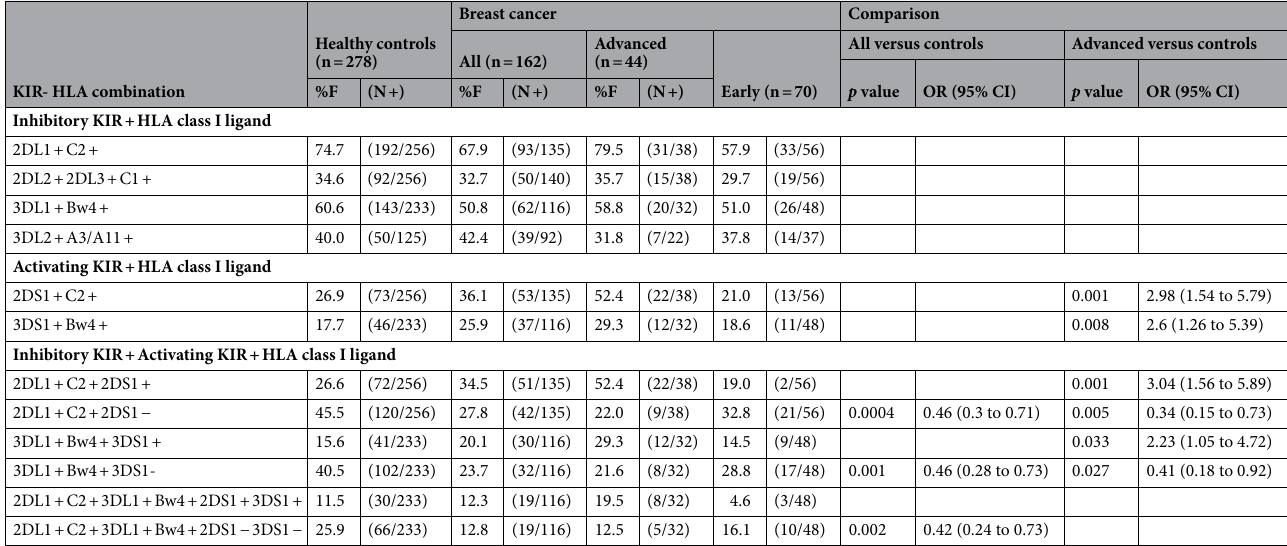
Table 2. Carrier frequency of KIR+HLA class I ligand combinations in breast cancer patients and